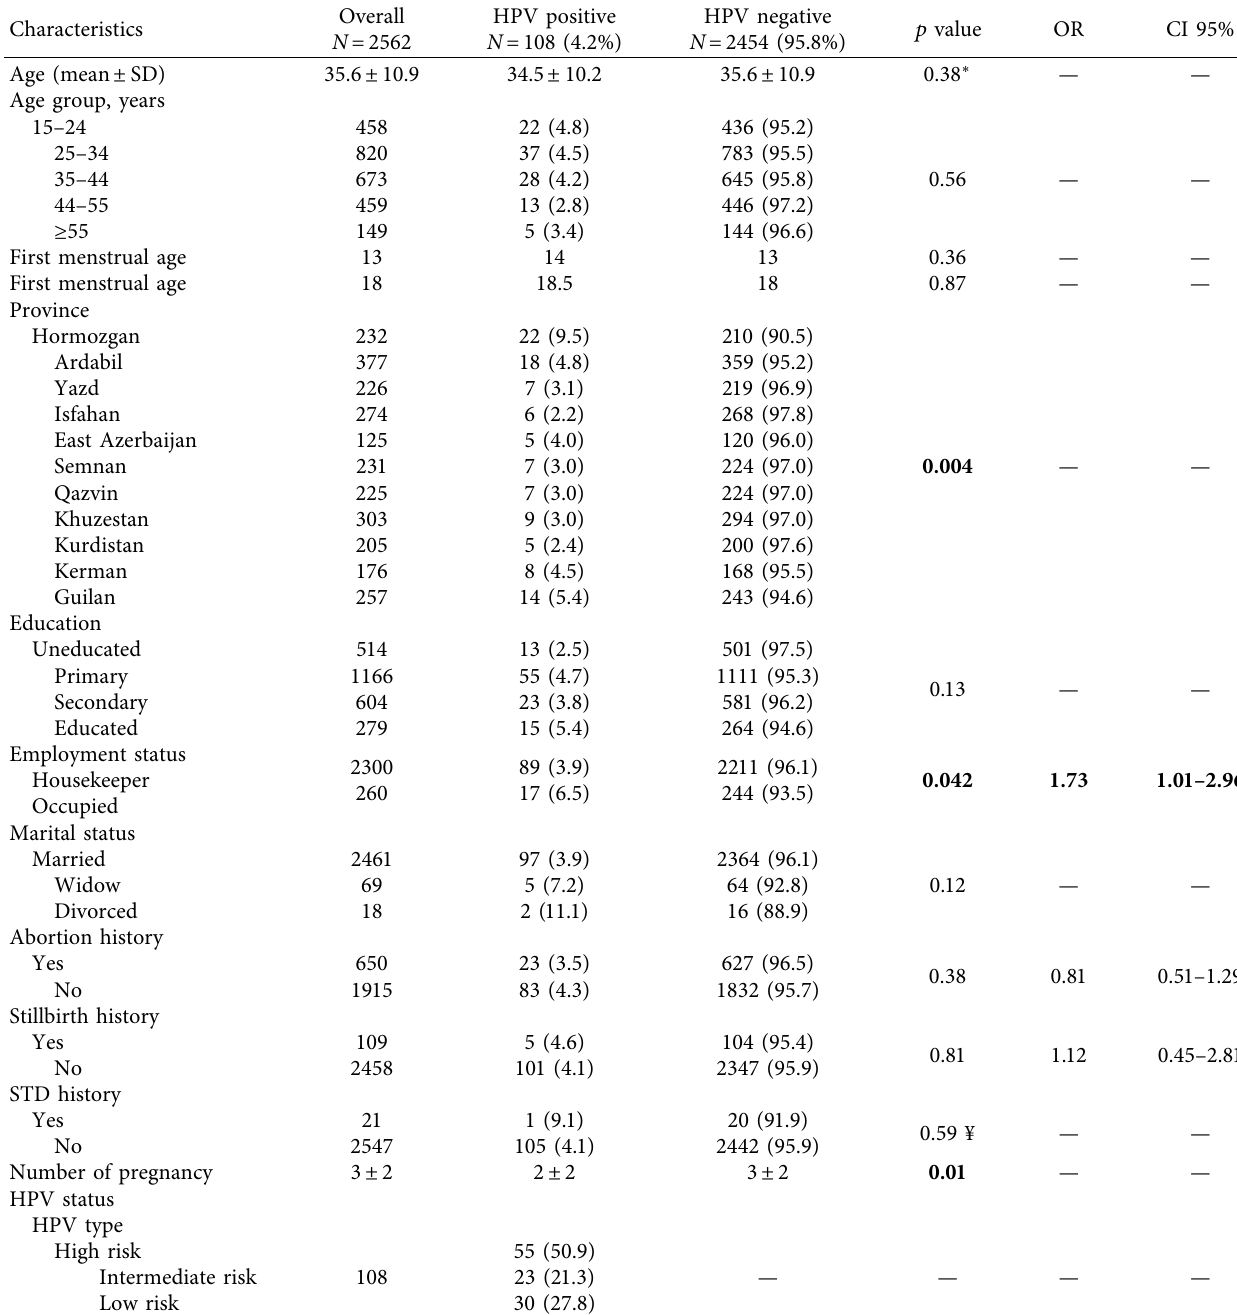
Table 1: Characteristics in HPV positive and negative